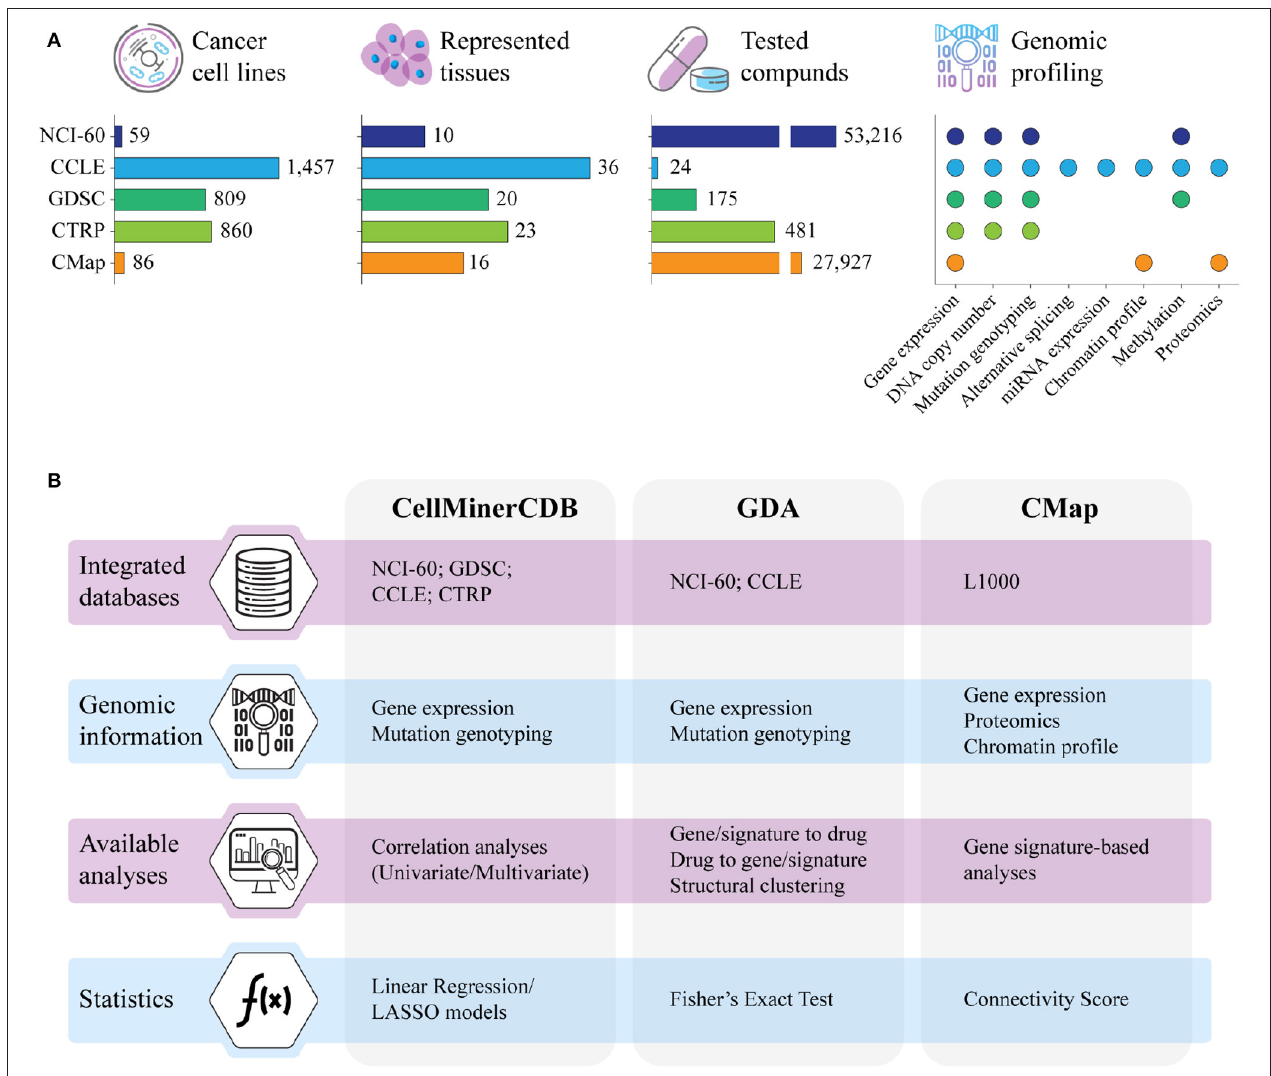
FIGURE 1 | (A) Summary of the major resources of pharmacogenomics data in terms of number of cell lines with genomic data, represented tissues, tested compounds, and type of genomic information. NCI-60; CCLE, Cancer Cell Line Encyclopedia; GDSC, Genomics of Drug Sensitivity in Cancer; CTRP, Cancer Therapeutic Response Portal; CMap, Connectivity Map. (B) Main characteristics of CellMinerCDB, Genomics and Drugs integrated Analysis portal (GDA), and CMap, the computational resources for the integrative analysis of pharmacogenomics data that are described in this review. LASSO, least absolute shrinkage and selection